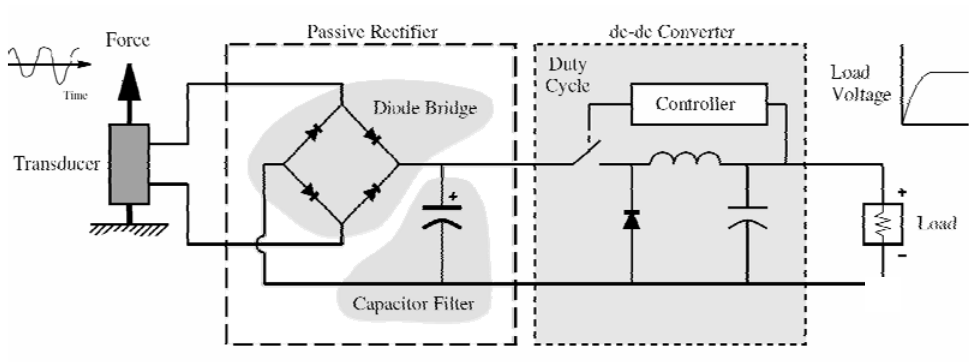
Figure 15 : Passive rectifier with dc-dc converter